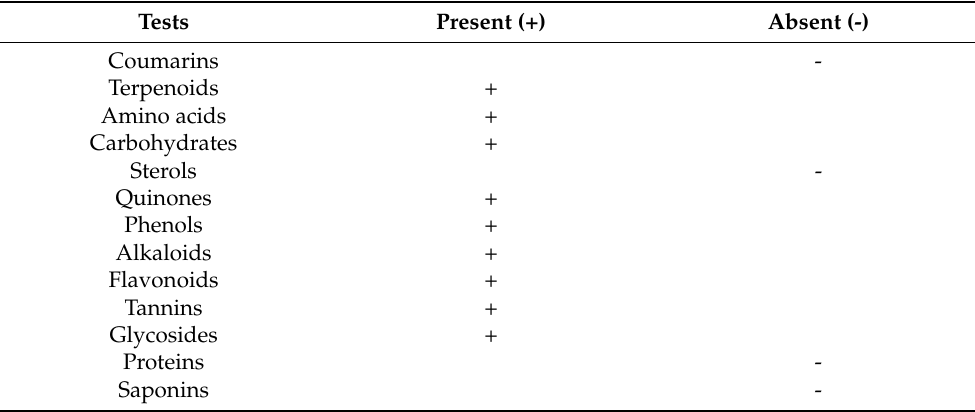
Table 1. Qualitative phytochemical analysis of T. couneifolia methanolic